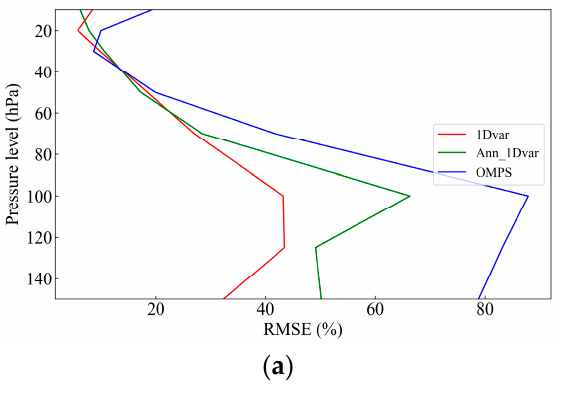
Figure 8. A comparison of the retrieval profile and OMPS product profile, where the true value is taken from ERA5 data: ( a ) RMSE (%); ( b ) ME (%). The red line, 1Dvar, is the traditional 1D − VAR physical retrieval algorithm retrieval ozone profile result obtained with GFS data as the initial profile. The green line, Ann_1Dvar, is the retrieval result obtained by adding the neural network method to optimize the initial profile combined with the traditional 1D − VAR physical retrieval algorithm. The blue line, OMPS, is the ozone profile of the OMPS L2 ozone product.